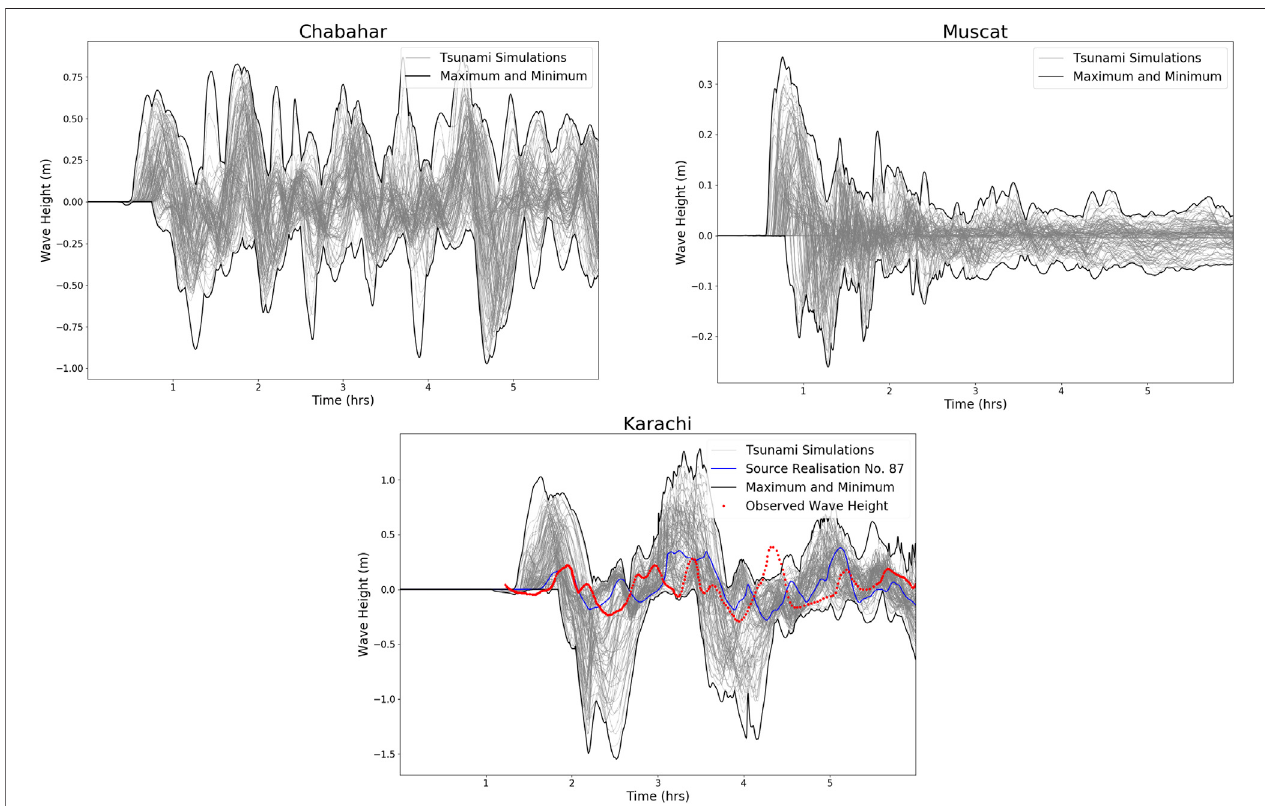
FIGURE8| WaveheighttimeseriesplotsatChabahar,MuscatandKarachifromthe100Volna-OP2simulations.Theoutputfromeachsimulationisplottedingrey while the maximum and minimum wave heights at each point in time is plotted in black. The closest match (blue) to the observed wave gauge measurement from the 1945 event at Karachi is plotted along with the gauge signal (red dots).